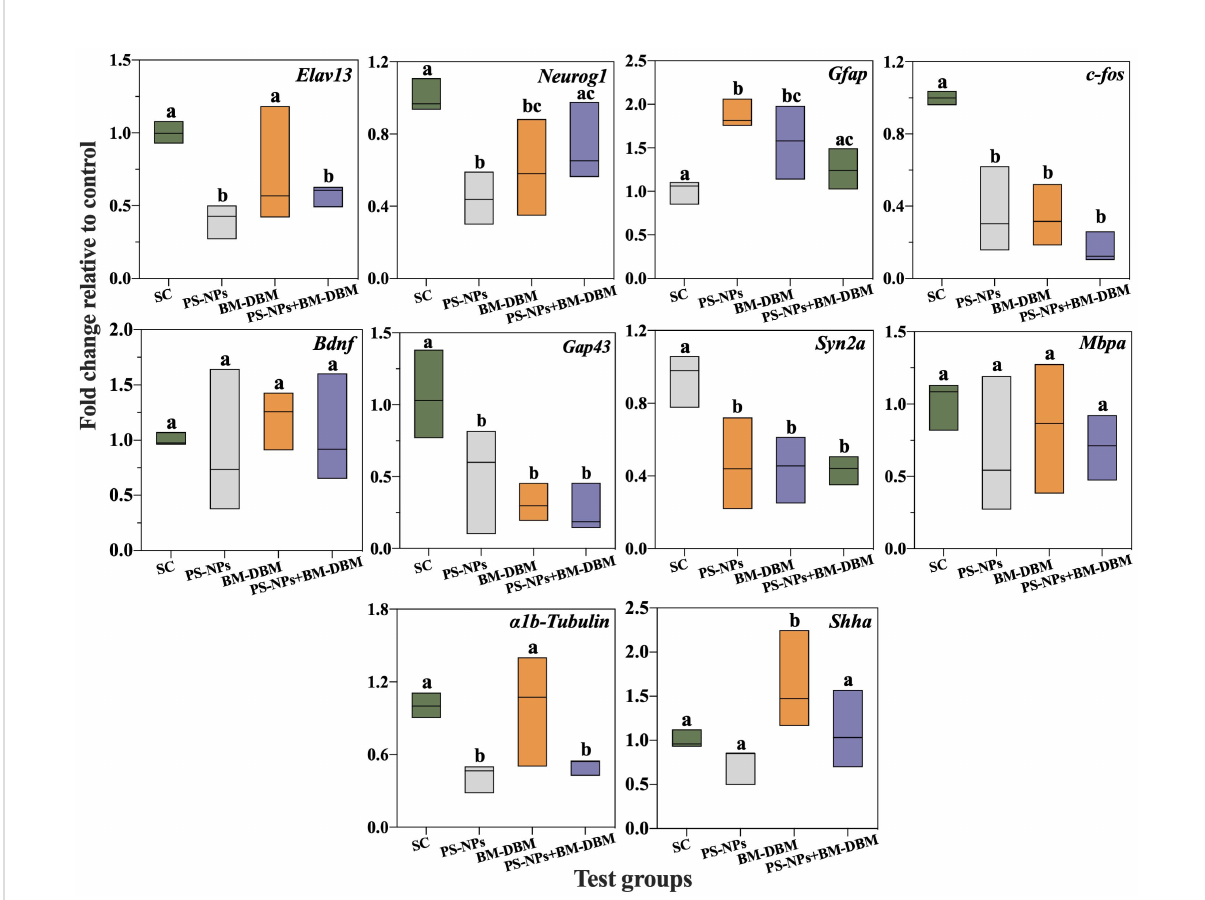
FIGURE 5 Expression of genes related to CNS development in larvae exposed to BM-BDM and PS-NPs alone or in combination. SC represents the solvent control group. Groups that did not contain the same letter were signi fi cantly different (P <